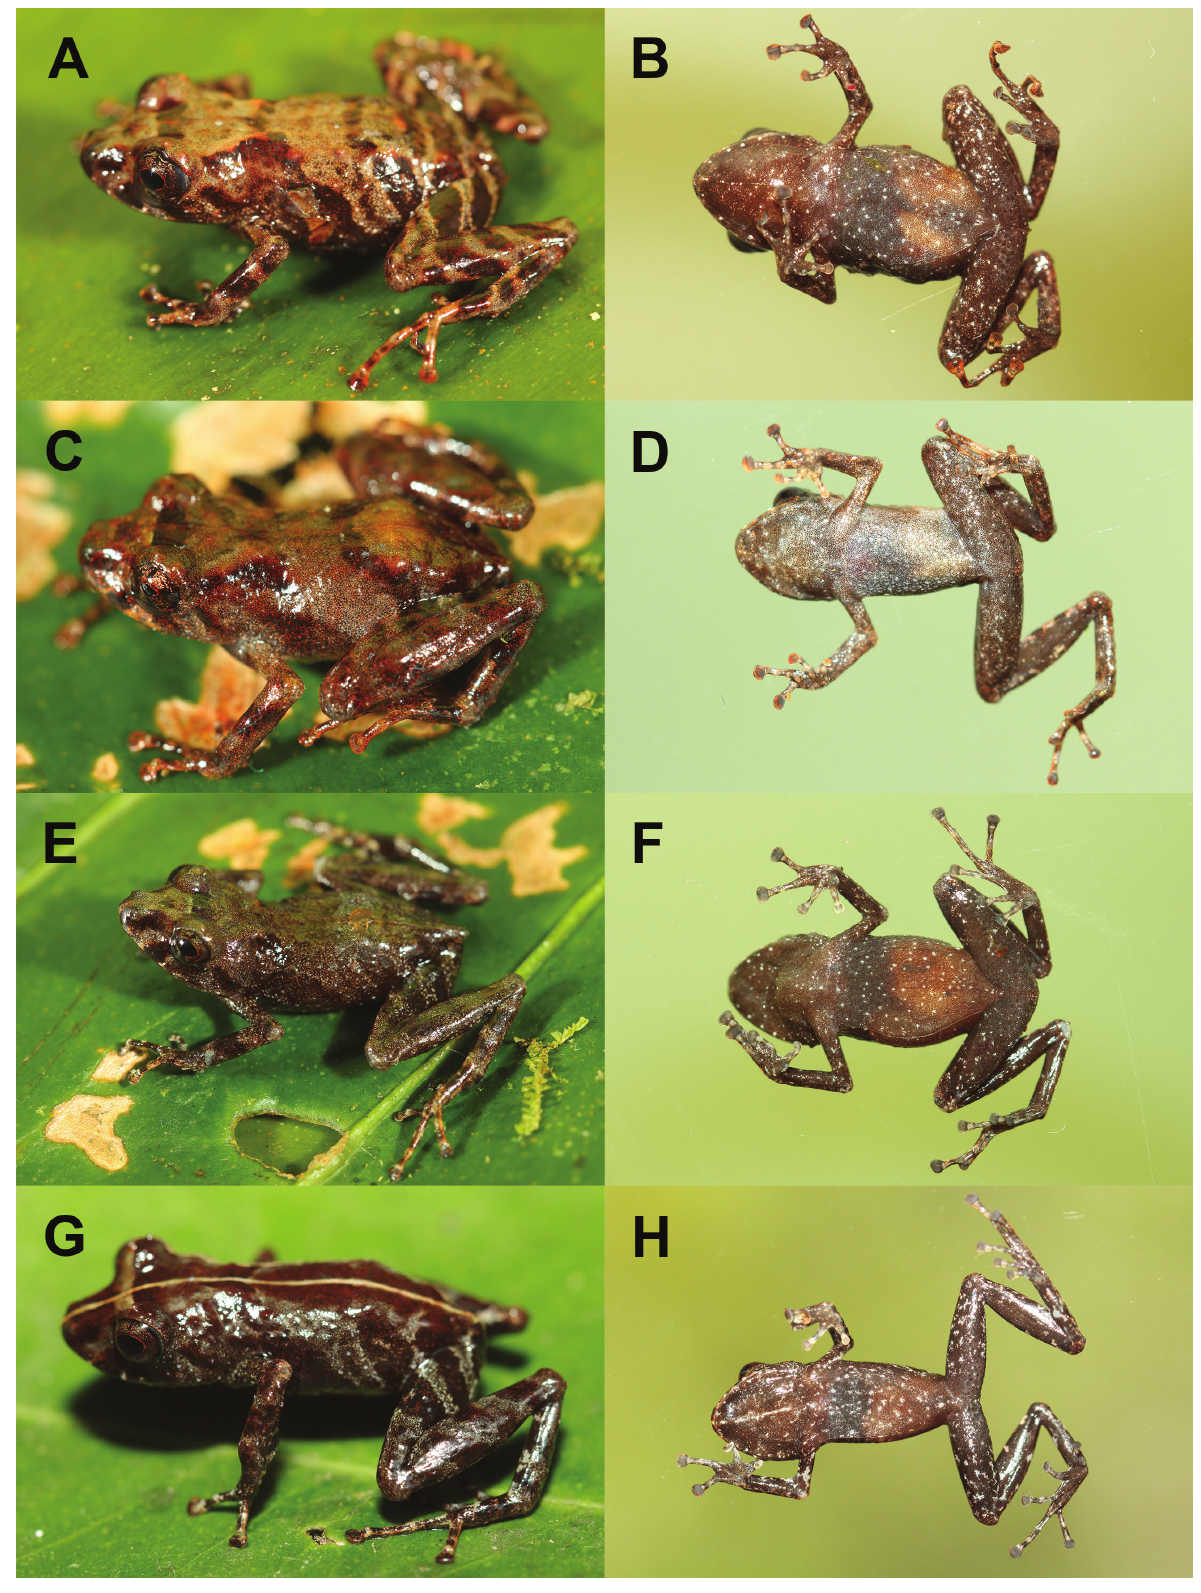
Figure 3. Coloration in life of the type series of Pristimantis sira sp. nov.: ( A, B ) adult female (CORBIDI 14430, holotype); ( C, D ) adult male (CORBIDI 14433); ( E, F ) adult female (CORBIDI 14429); ( G, H ) juvenile male (CORBIDI 13952). Photo- graphs by Germán